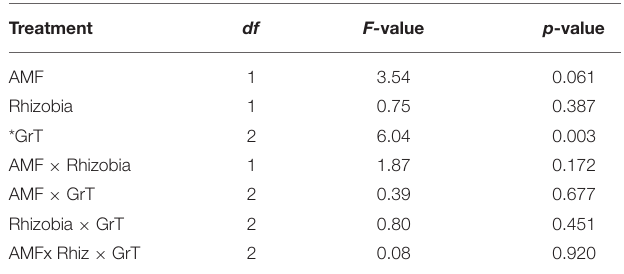
TABLE 1 | Three-way ANOVA results for dry mass of the above-ground tissue in microbial, gravitational treatments (GrT), and microbial × gravitational treatment groups.